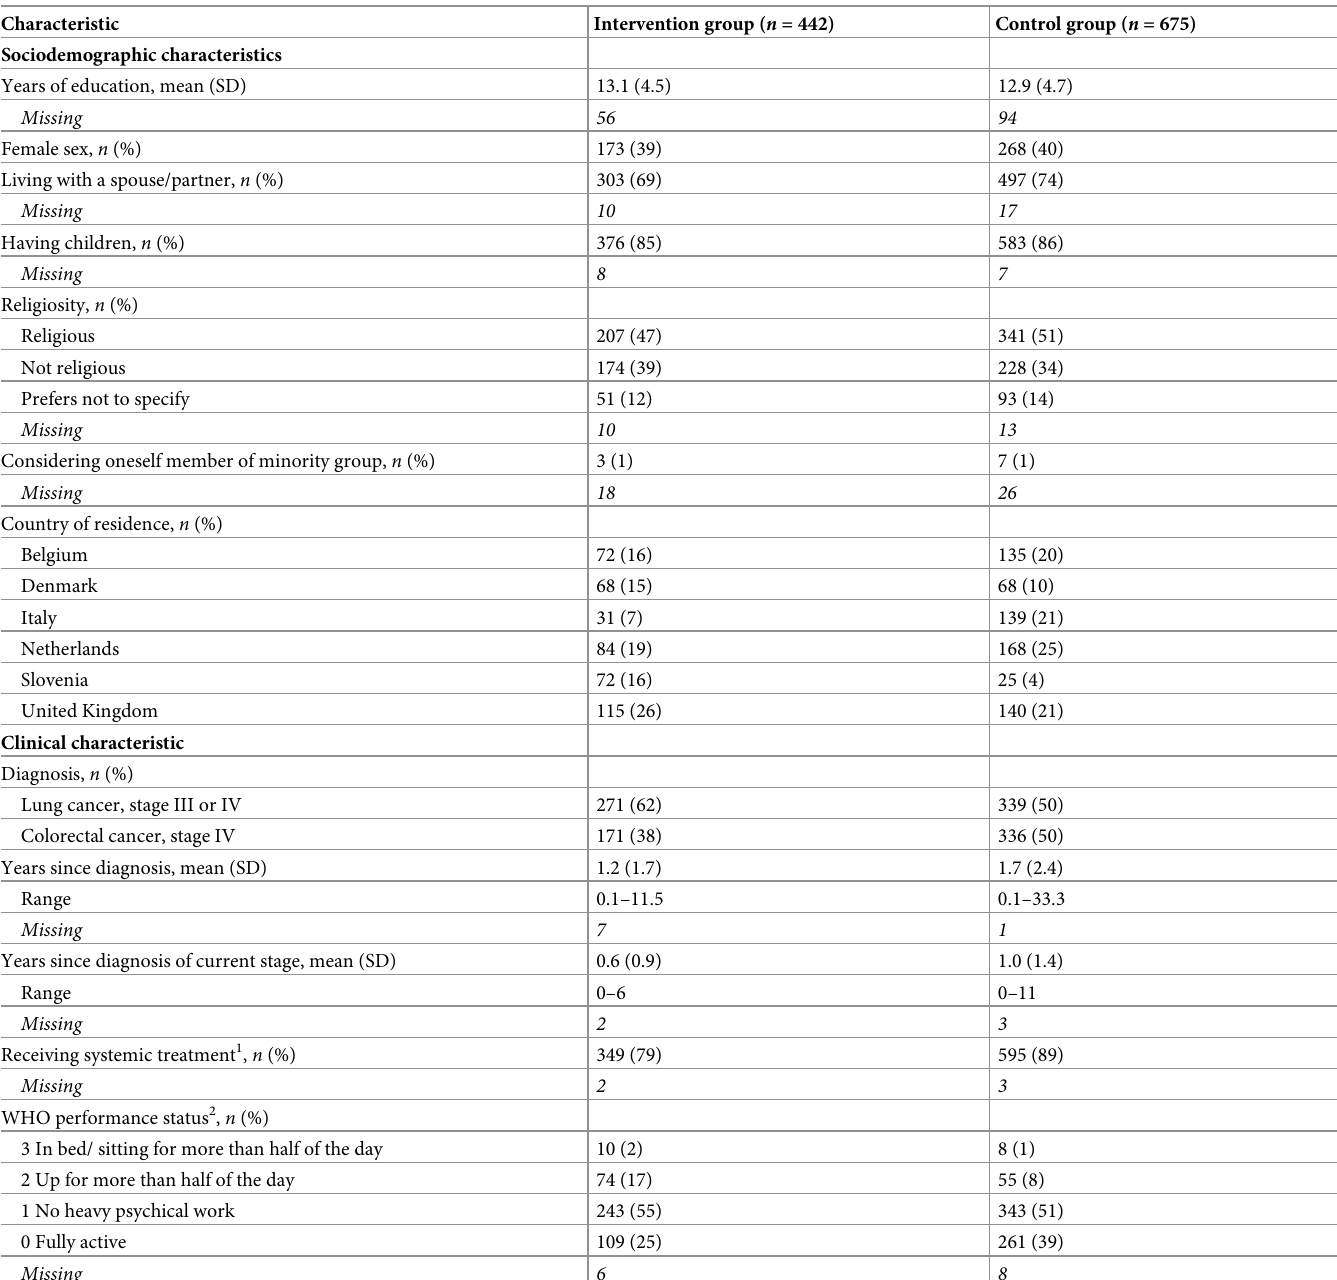
Table 1. Sociodemographic and clinical characteristics of ACTION participants.